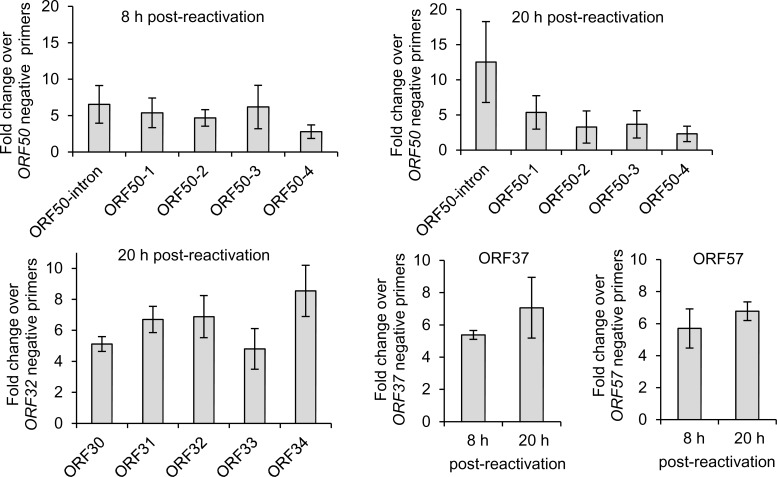
Validation of m6A peaks.Total RNA isolated from TREx BCBL1-Rta cells was chemically fragmented and subjected to m6A-IP-qRT-PCR. Primers specific for regions spanning m6A peaks were designed as positive control primers. ORF50-1, ORF50-2, ORF50-3 and ORF50-4 indicate primers that generate an amplicon spanning the first, second, third and fourth m6A peaks of the second exon of ORF50 transcript respectively. ORF50-intron primers generate an amplicon spanning the m6A peak in the ORF50 intron. ORF50 negative primers were designed at the start of the second exon of ORF50 mRNA. ORF57 positive primers span the tallest m6A peak in the second exon of ORF57 mRNA while negative primers span the first m6A peak in the ORF57 second exon. ORF32 and ORF37 negative primers were positioned at the start of the coding region of ORF32 and ORF37 respectively. % of recovered input was calculated for each region of interest and the fold change over the % of input of control negative primers was calculated. For all figures, values are averages, error bars present s.d. n ≥ 3 independent m6A-IPs, each from an independent viral reactivation.